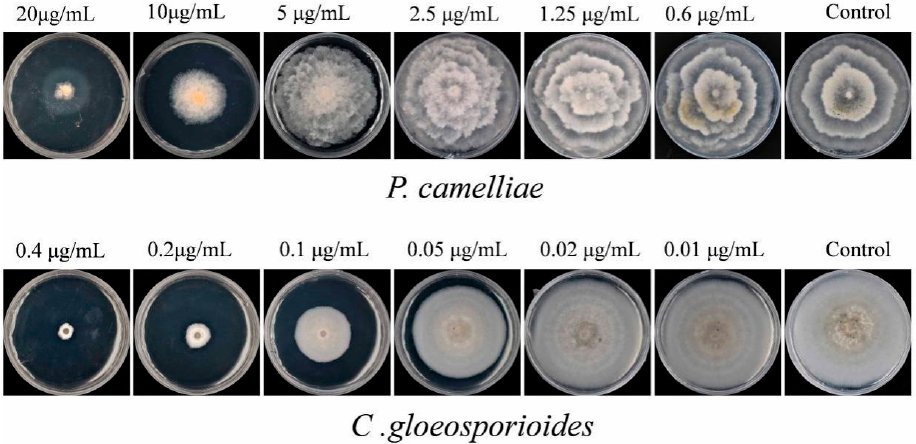
Figure 7. The mycelial growth of C. gloeosporioides and P. camelliae treatment by commercial fungicide carbendazim (positive control) with contact antifungal activity after 7 days.